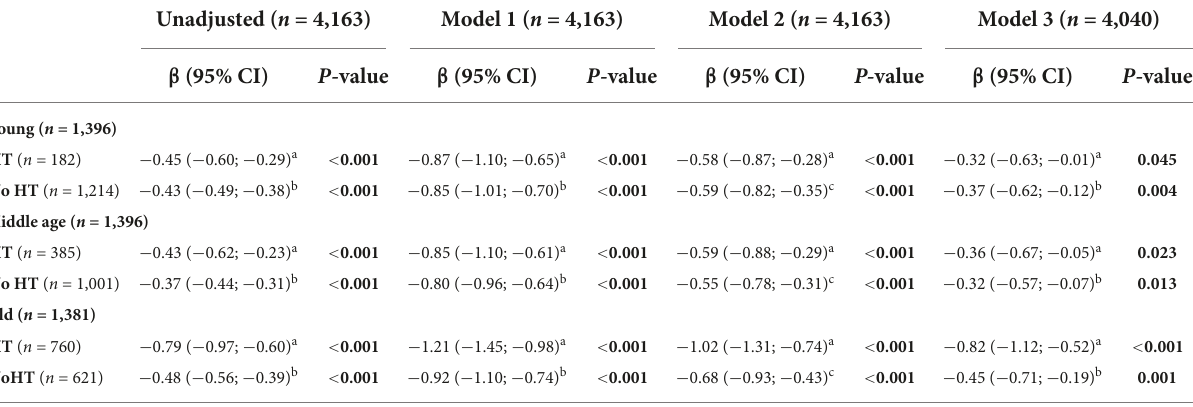
TABLE 2 Linear regression using tertiles of age as a predictor of kidney function decline stratified according to the presence of hypertension ( n = 4,163). Unadjusted ( n = 4,163)